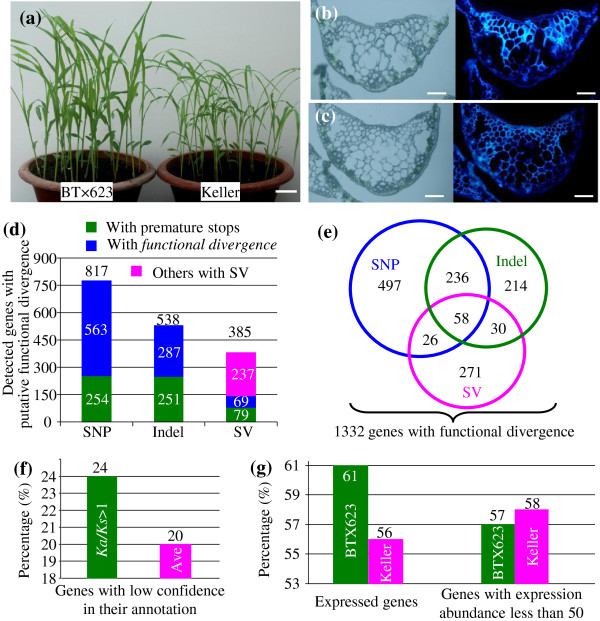
Phenotypic and genotypic variations between BT×623 and Keller. (a) Comparison between BT×623 and Keller at seedling stage. Bar in (a) is 3 cm. (b) and (c) Cross-sections of BT×623 and Keller leaves at the mid-rib regions under light microscopy (left) and under UV light with epifluorescence (right), respectively. Bars in (b) and (c) are 150 μM. (d) Detected genes with putative functional divergence with either premature stops or Ka/Ks>1. (e) Summary of genes with functional divergence. The venn diagram shows the relationship of divergent genes in their variation types. The blue, green and pink circles indicate the genes with variations from SNP, Indel and SV, respectively. (f) Percentage of genes with Ka/Ks>1 and with low confidence in their annotation. (g) Analysis of expression abundance of genes with functional divergence.